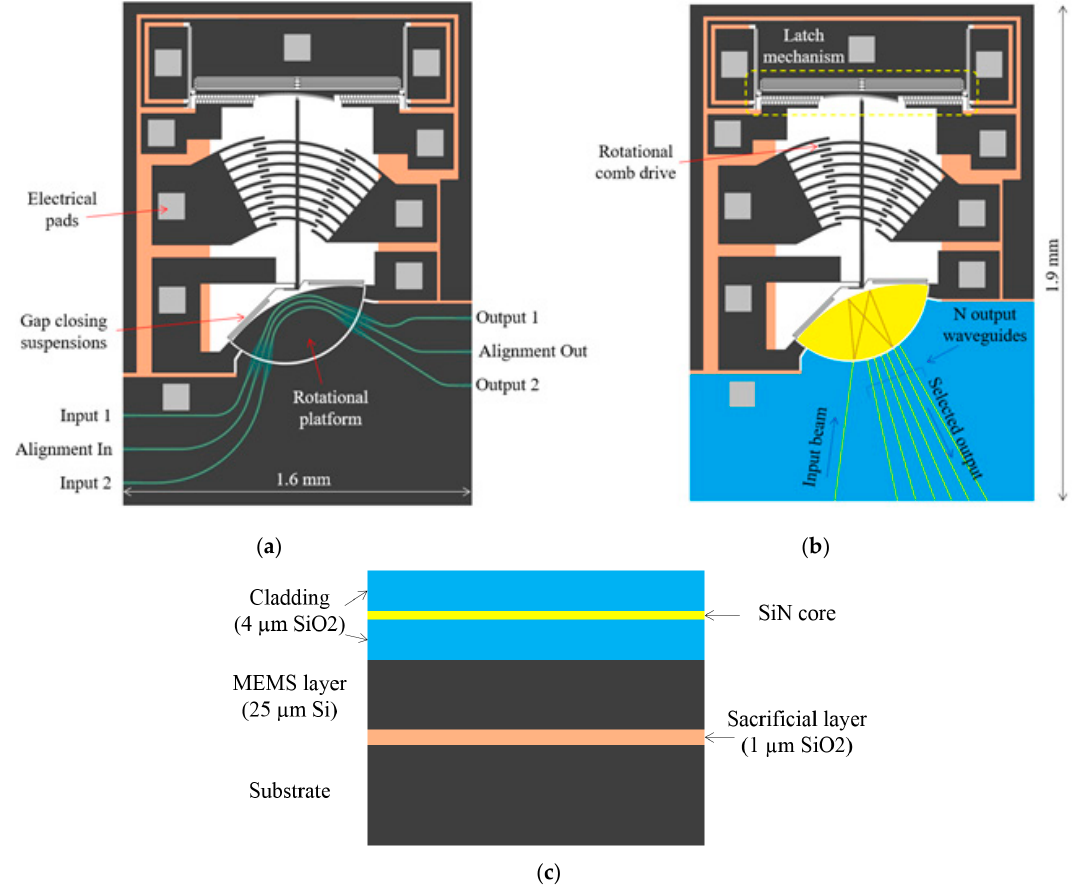
Figure 1. Example applications of the proposed actuator: ( a ) schematic of the crossbar switch; ( b ) schematic of the 1 × N mirror-based switch; ( c ) cross-section of the key material stack.